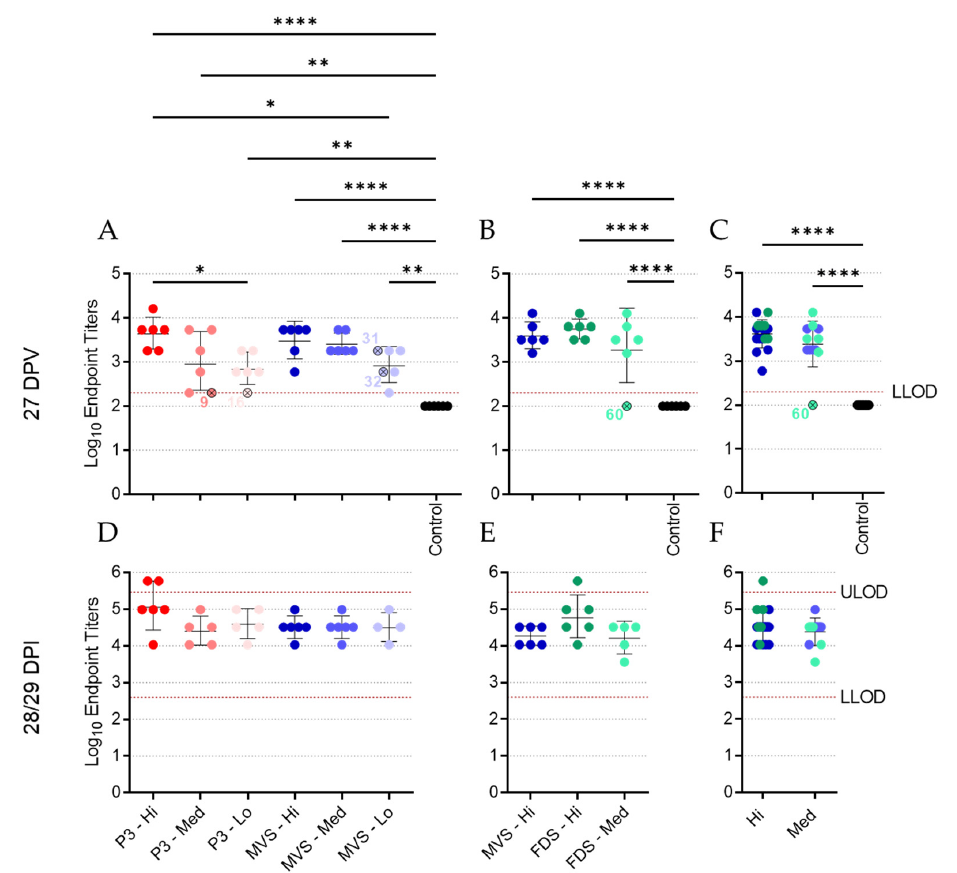
Figure 5. Anti-MARV GP IgG levels following vaccination and MARV challenge. Plasma samples from Experiment #1 ( A , D ) or serum samples from Experiment #2 ( B , E ) were obtained from all guinea pigs at 27 DPV ( A , B ) and 28 or 29 DPI ( D , E ) and assessed for levels of MARV GP-specific IgG via ELISA. Data are presented as endpoint titers, with geometric means and standard deviation for each group depicted behind individual values for each animal. Data from the high and medium dose levels for the PHV01 MVS and PHV01 FDS groups were pooled to assess dose-dependent effects ( C , F ). Vaccinated animals that did not survive infection are indicated with an “x” and labelled with the animal number. The lower limit of detection (LLOD) and upper limit of detection (ULOD) of the assays are labelled and indicated with a red dashed line. *, p ≤ 0.05; **, p ≤ 0.01; ****, p ≤